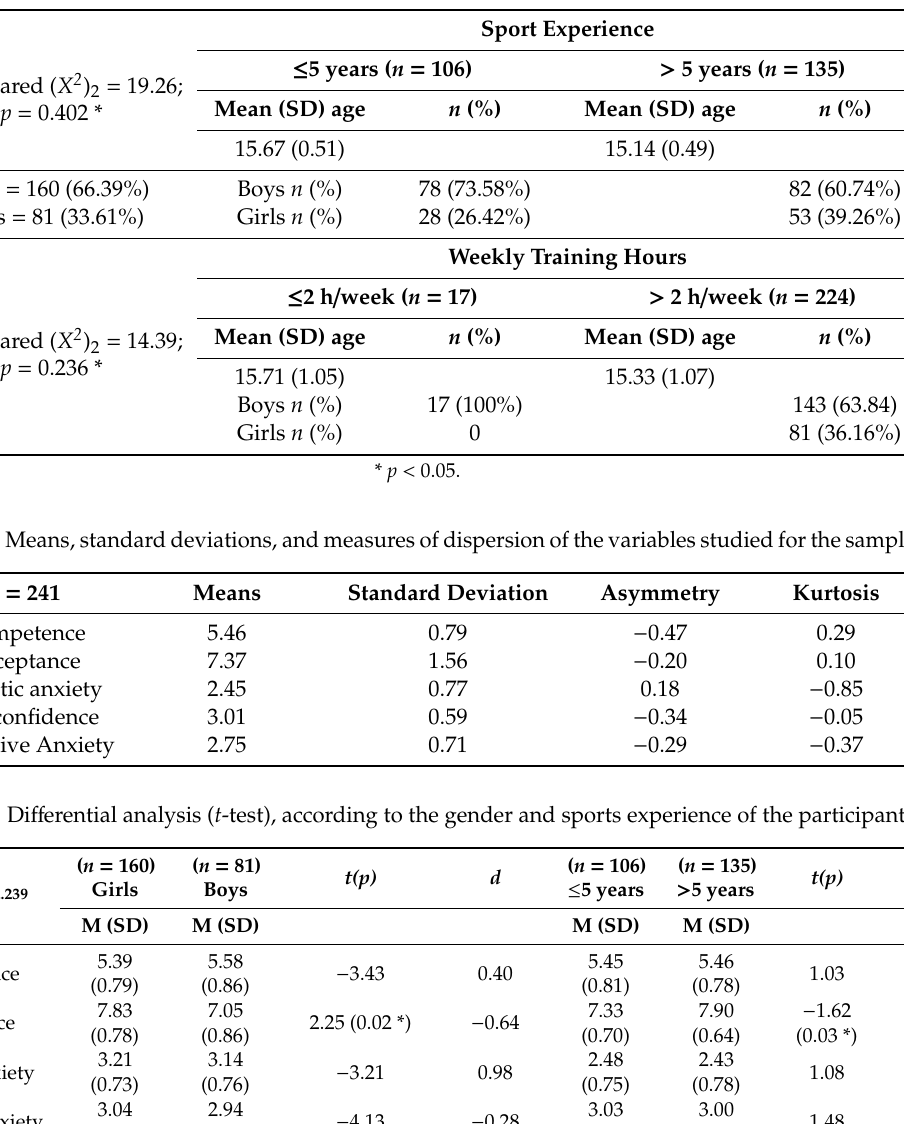
Table 1. Distribution and homogeneity of intervariable variances (gender, sport experience, and weekly training hours).